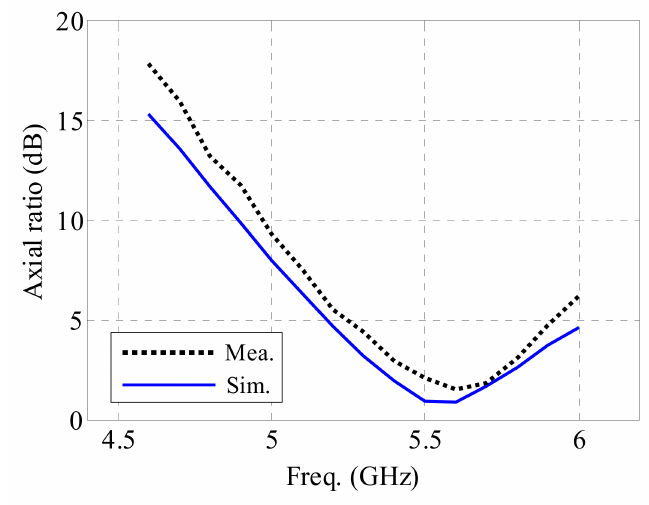
Figure 13. AR values in the z -axis direction in the higher band.